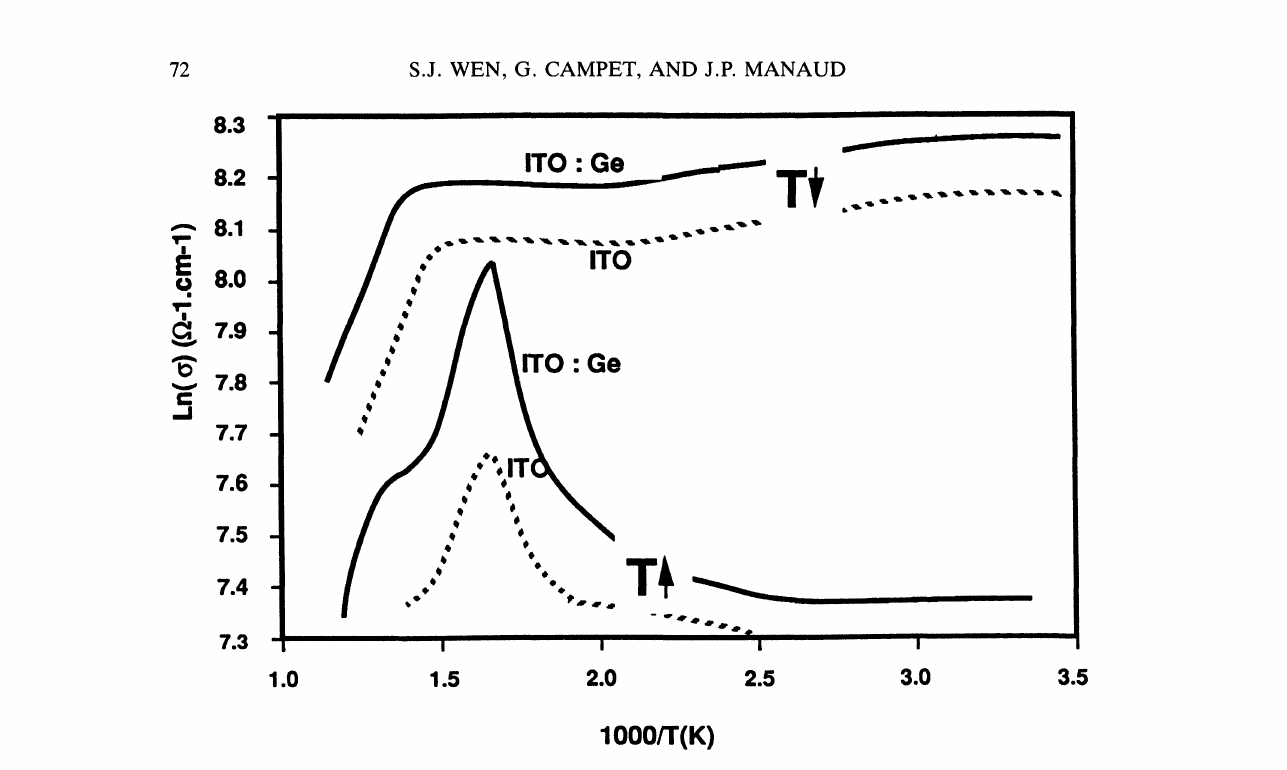
Influence of the arrangement of crystallite size on the conductivity for ITO and ITO’Ge films deposited on glass